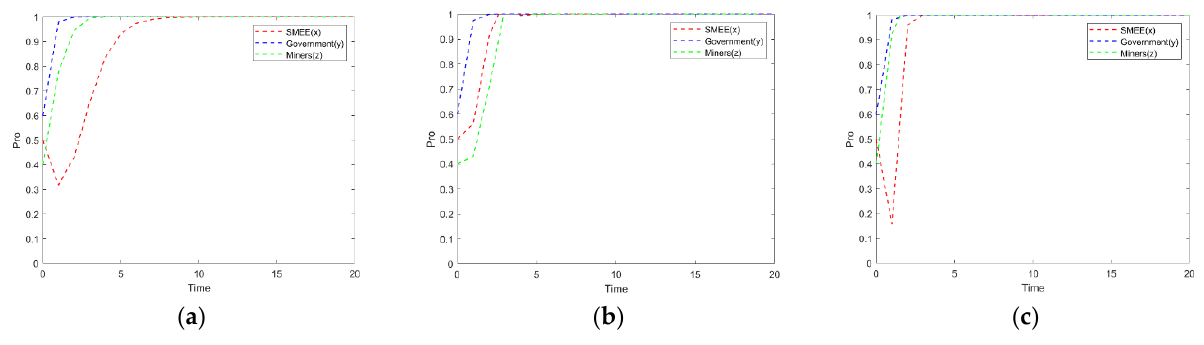
Figure 7. C b = 1.5 , strategy evolution process of the three game subjects under 3 emotional states of the miner. ( a ) 𝑟 1 = 𝑟 2 = 𝑟 3 = 1 ; ( b ) 𝑟 3 < 1 , 𝑟 1 = 𝑟 2 = 1 ; ( c ) 𝑟 3 > 1 , 𝑟 1 = 𝑟 2 = 1 .